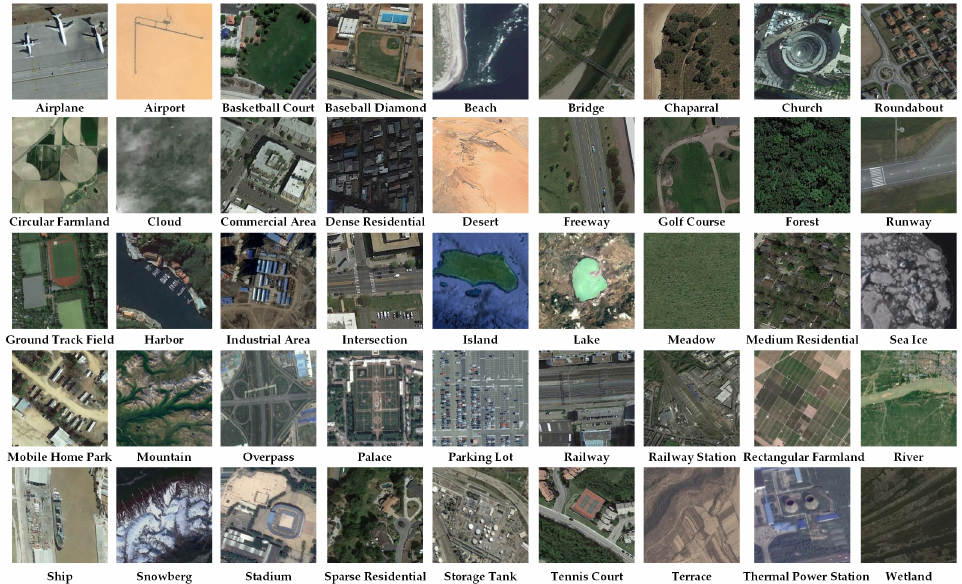
Figure 8. Instance samples in